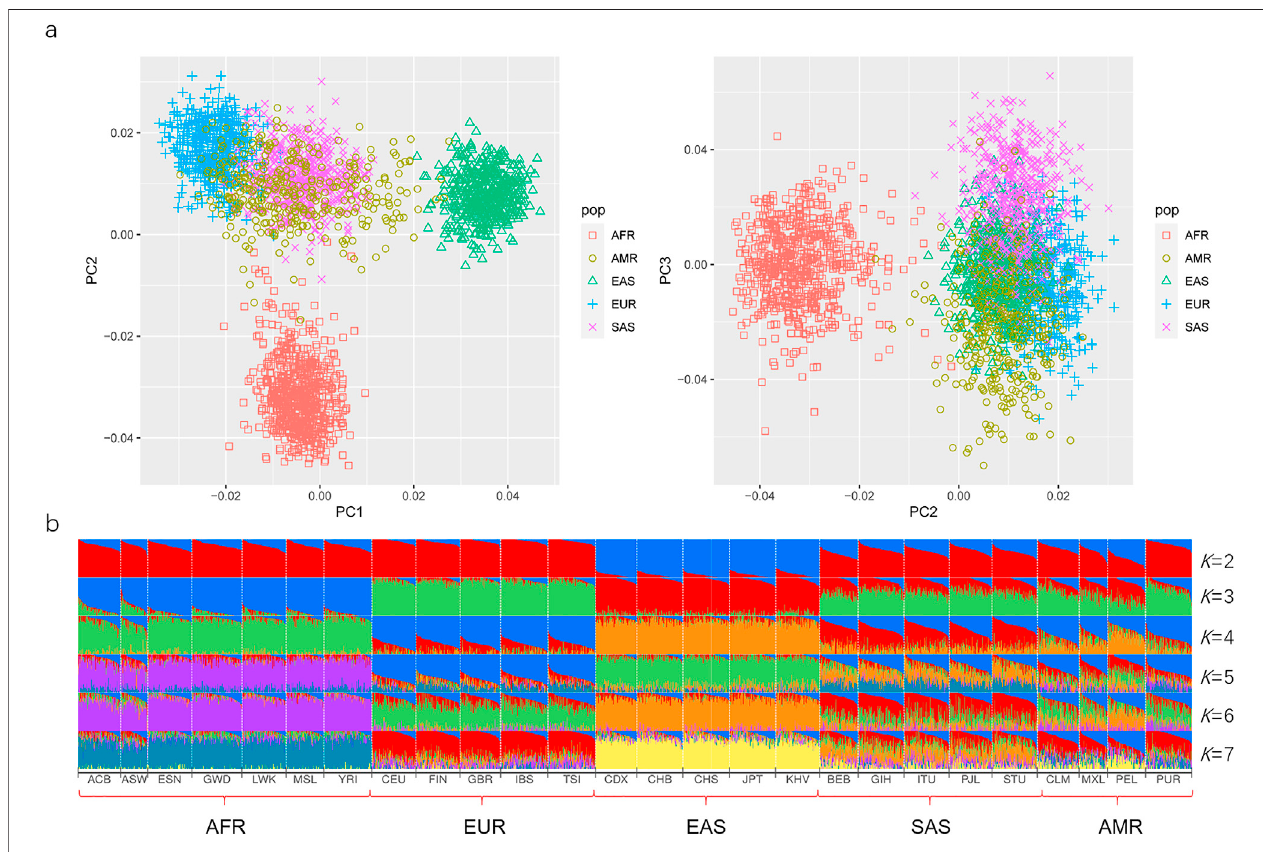
FIGURE4| Ancestryoriginanalysesofdifferentcontinentalpopulationsbasedon50ancestryinformativeDIPs. (A) PCAofdifferentcontinentalpopulationsatPC1, PC2, and PC3. (B) Population genetic structure analyses of different continental populations at K (cid:1) 2 – 7.